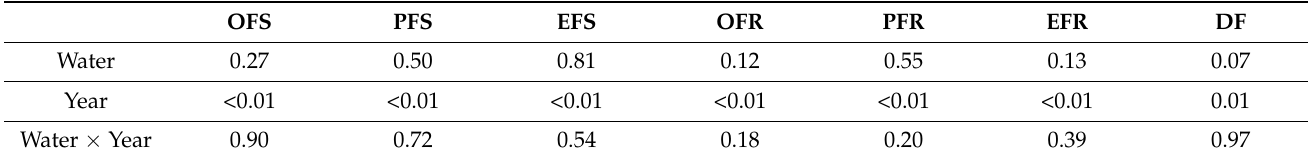
Table 1. The p -values of the linear mixed model (MIXMOD) analysis on the fixed effects of water addition treatments (water), year, and their interaction on the fruiting events and the duration of the fruiting stage (DF) from 2012 to 2018. OFS, PFS, and EFS represent the onset, peak, and end of the fruit setting stage, respectively. OFR, PFR, and EFR represent the onset, peak, and end of the fruit ripening stage,